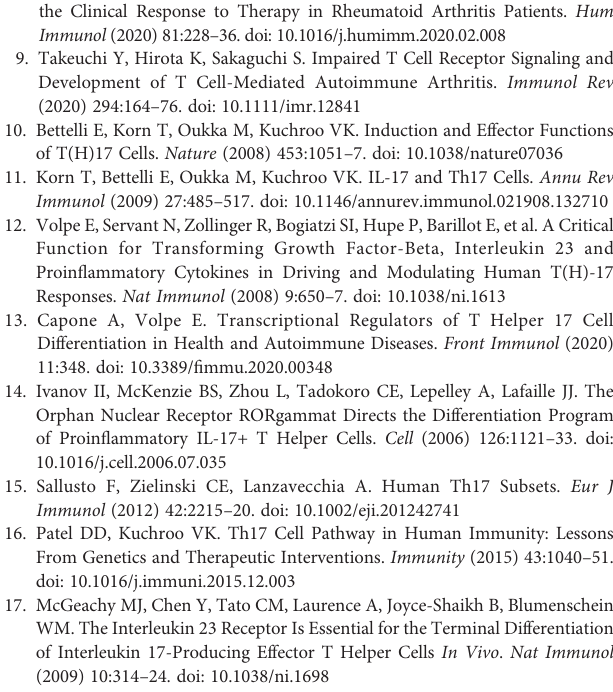
Supplementary Figure 1 | The potential value of circNUP214 in RA. ROC curve analysis of circNUP214 was performed to distinguish the RA patients from the healthy volunteers. The area under the ROC curve (AUC) was up to